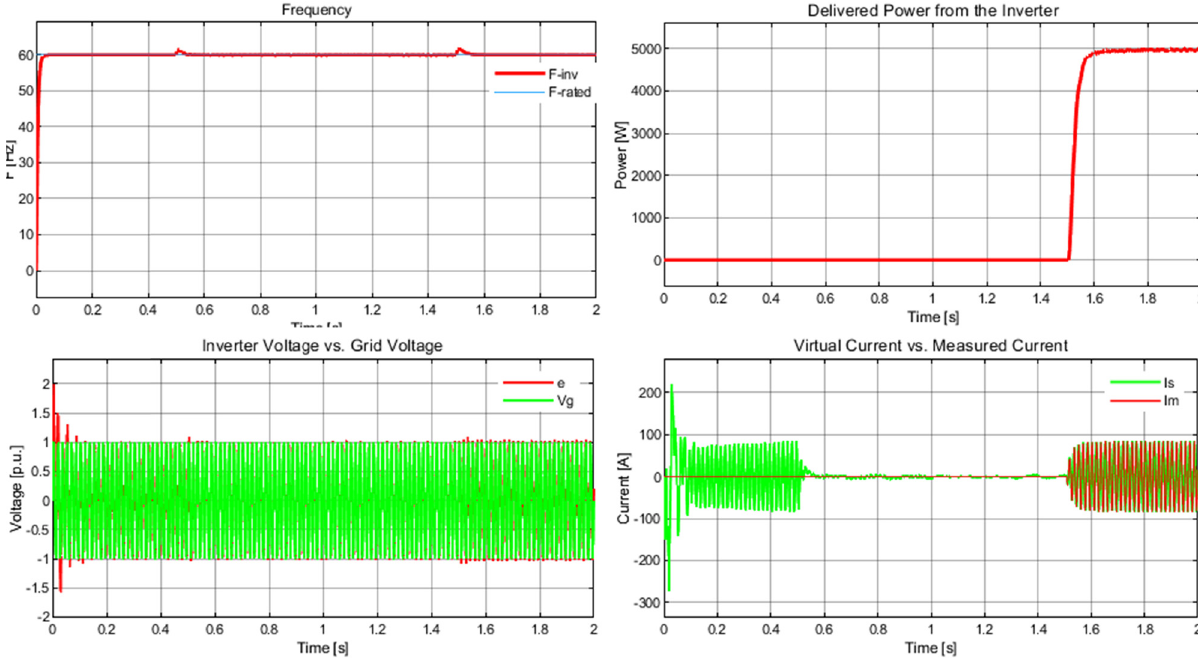
Figure 5: Results from Scenario 1 – connection to a balanced power